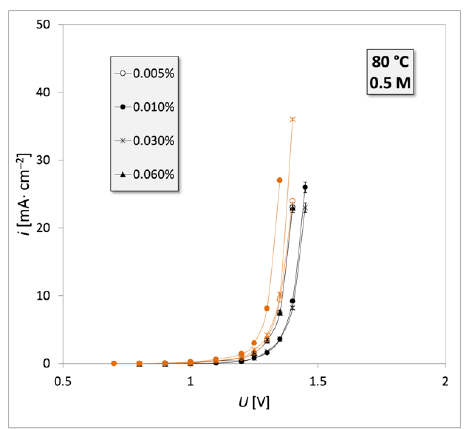
Figure 5. Electro-oxidation curves of Syntanol DS-10 detergent (orange lines) and waste engine oil emulsion (black lines) at the temperature of 80 ◦ C in a 0.5 M aqueous solution of H 2 SO 4 , for various concentrations of detergent and emulsion (0.005%, 0.010%, 0.030%, and 0.060% of reactor